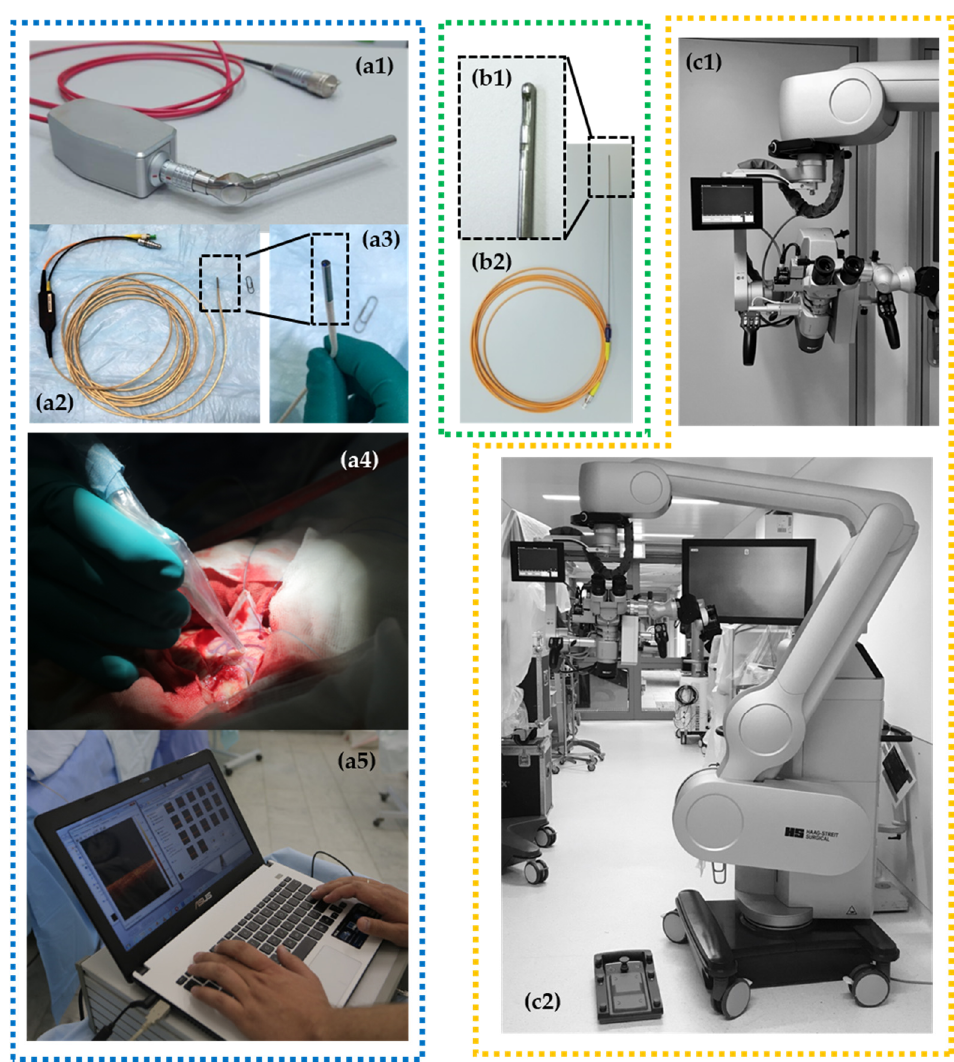
Figure 1. Different OCT devices are presented with corresponding types of OCT probes: (1) rigid curve-shaped ( a1 ) and flexible ( a2 , a3 ) handheld probes for intraoperative use with portable OCT device ( a5 ) and application during brain tumor removal ( a4 ); (2) needle-like probe ( b1 , b2 ) for stereotactic biopsy providing 2D images; (3) operating microscope with integrated OCT system providing OCT imaging directly in oculars and on a small-sided screen* fixed close to the microscope ocular ( c1 , c2 ).